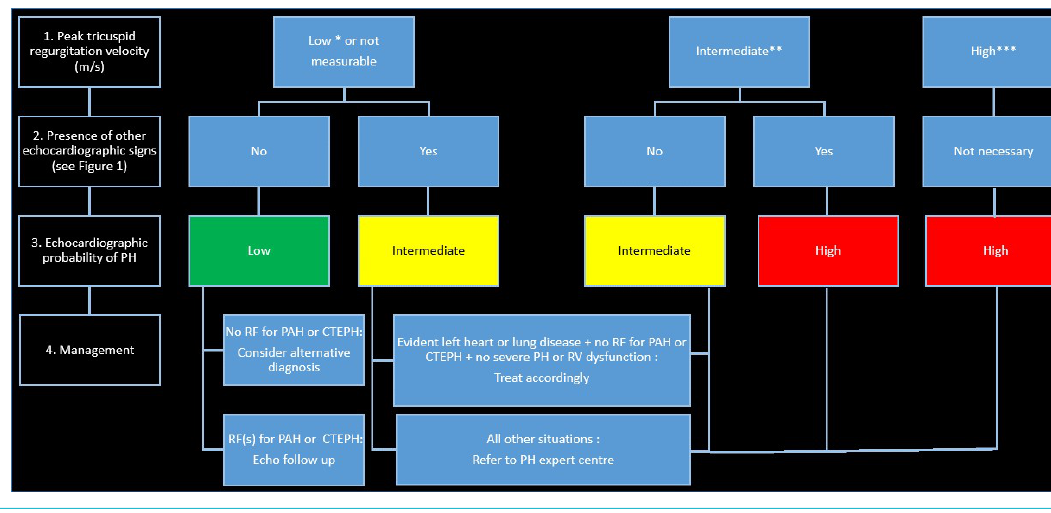
Figure 3: Evaluation of the echocardiographic probability of pulmonary hypertension and further management in a 4 steps approach. For man- agement, consider if the patient has risk factors (RF) or associated conditions for pulmonary artery hypertension (PAH), or chronic throm- boembolic pulmonary hypertension (CTEPH). Adapted from Galiè 2016 [1]. Other TTE signs are considered if ≥2 indices from ≥2 classes are present.* Low peak TRV = ≤2.8 m/s according to guidelines and ≤2.55 m/s according to epidemiological data (cf text). ** Intermediate peak TRV = 2.8–3.4 m/s according to guidelines; lower limit >2.55 m/s according to epidemiological data (cf text). *** High peak TRV = >3.4 m/s ac- cording to